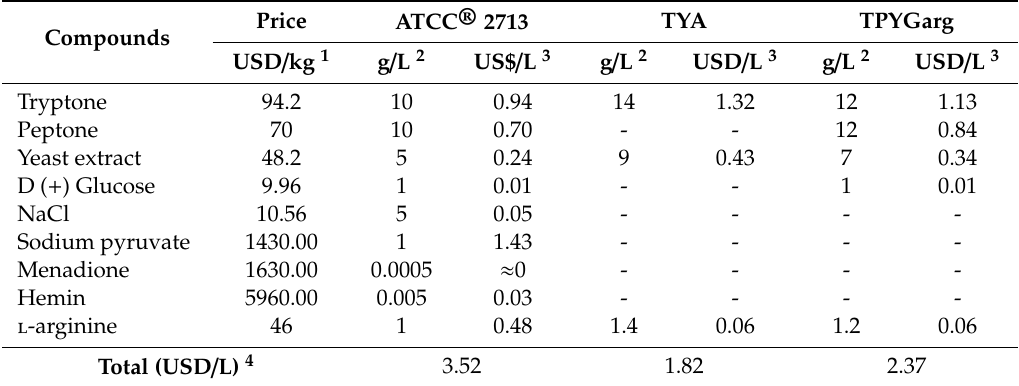
Table 8. Medium composition and cost of ATCC ® 2713, Tryptone, yeast extract, and l -arginine (TYA) and Tryptone-Peptone-Yeast extract-Glucose-Arginine